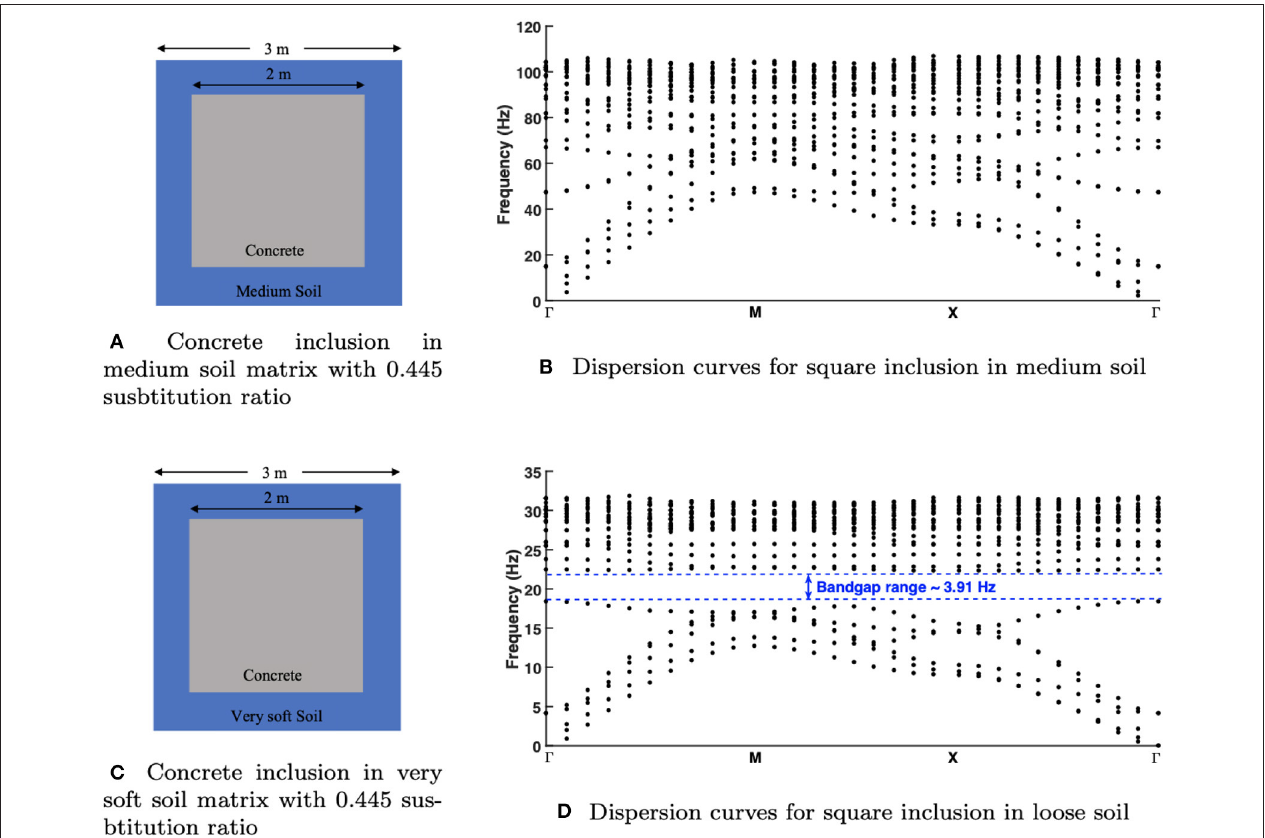
FIGURE 8 | Unclamped configuration of concrete inclusion (with 0.445 substitution ratio) in (A) medium soil ( E = 153 MPa, µ = 0.33, and ρ = 1,800 kg / m 3 ); (C) very soft soil ( E = 10 MPa, µ = 0.25, and ρ = 1,400 kg / m 3 ). Corresponding dispersion curves obtained are shown in (B,D) , around the edges of the irreducible Brillouin zone Ŵ XM . No bandgap is observed with the medium soil matrix; whereas in very soft soil a bandgap, ∼ 3.91 Hz, is observed.